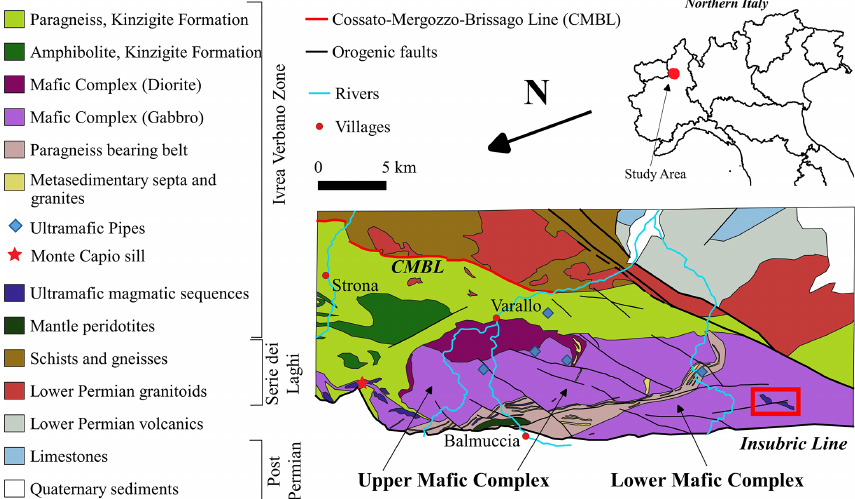
Figure 1. Geological map of the central Ivrea–Verbano Zone and Serie dei Laghi, simplified after Sinigoi et al. (2016). Location of the ultramafic pipes after Guergouz et al. (2018). The north orientation aims at elucidating the inferred Permian stratigraphy. The red frame refers to the location of the Rocca d’Argimonia sequence (see Fig.